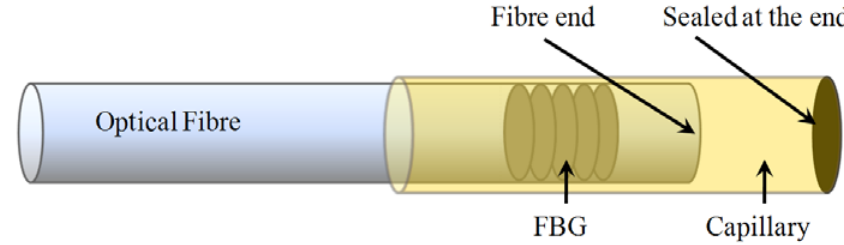
Figure 9. Schematic of an optical fibre Bragg grating embedded in a capillary to exclude all external stress/strain